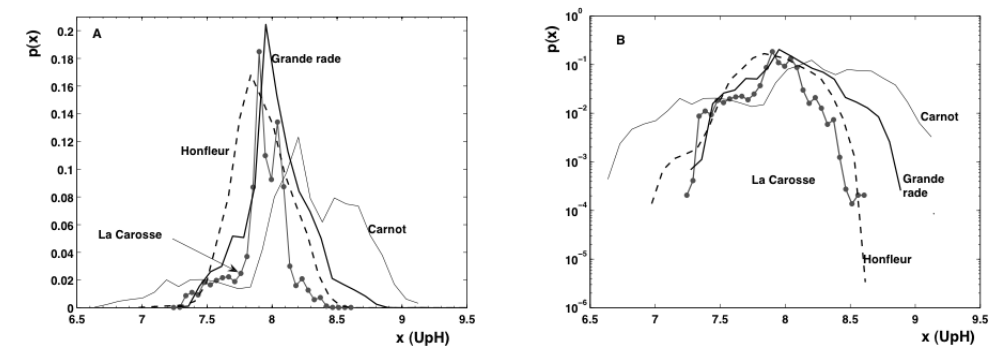
Fig. 5. Probability density function of the pH values: (A) in linear units and (B) in log-linear